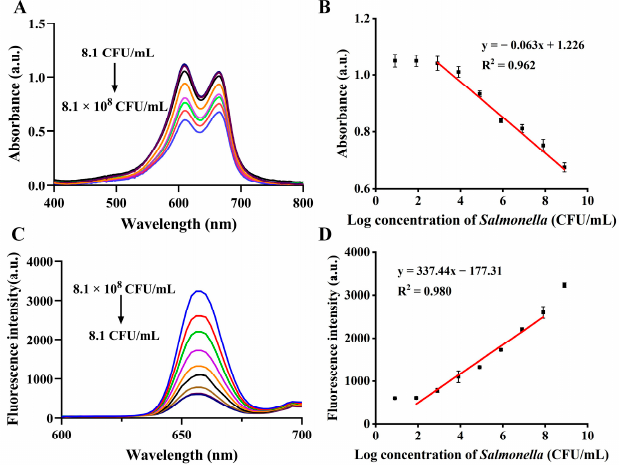
Figure 5. UV-Vis absorption spectra ( A ) and the absorbance calibration curve at 664 nm ( B ) for different Salmonella concentrations in the colorimetric assay. Fluorescent spectra ( C ) and the calibration curve of fluorescent intensity at 656 nm ( D ) for different Salmonella concentrations in the fluorescence assay.